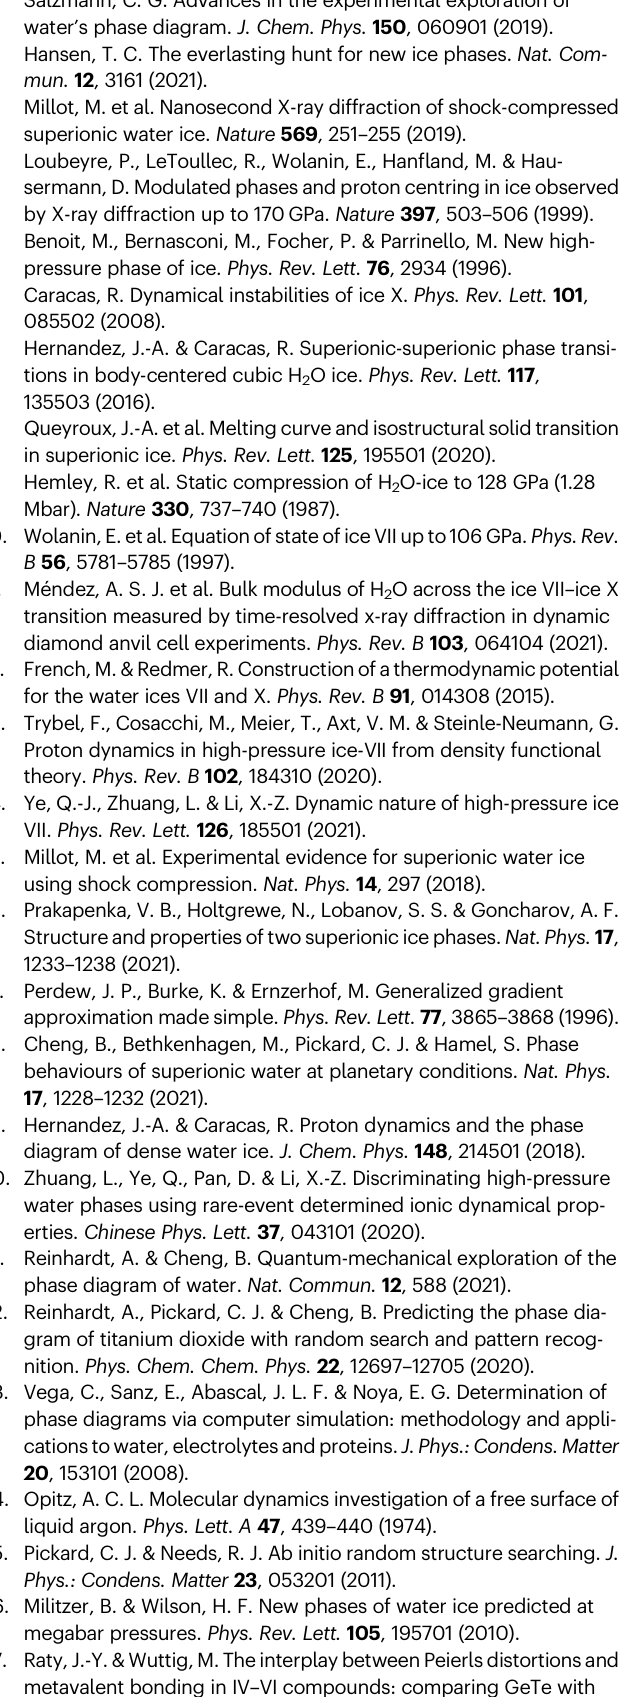
Fig.9.Toaccountforthein fl uenceofNQEsonthefreeenergies,weran path-integral molecular-dynamics (PIMD) simulations on small sys- temswith64 H 2 O formulaunitsusingLAMMPS inconjunctionwiththe